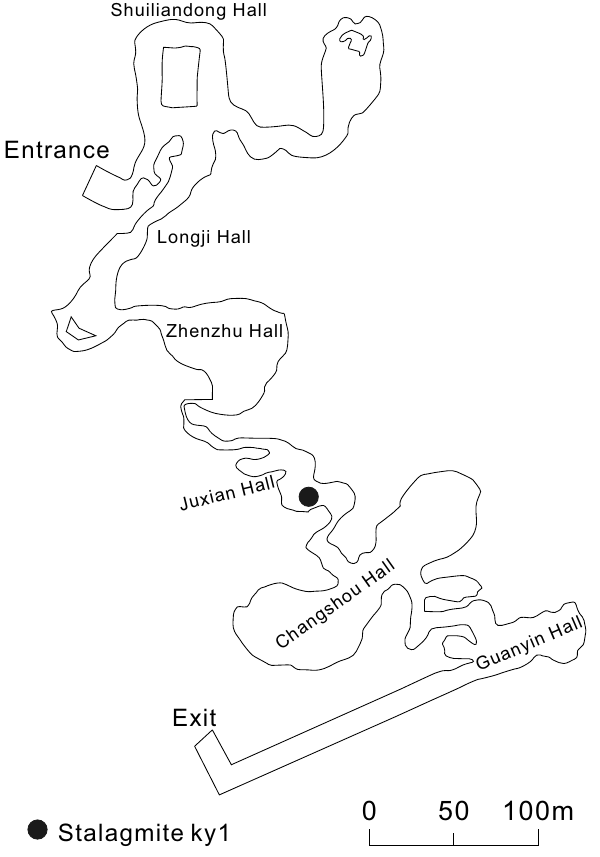
Figure 1. The map of Kaiyuan Cave. The black point is the location where we collected the sample in the cave. The cave has an entrance and an exit and consists of six small halls.